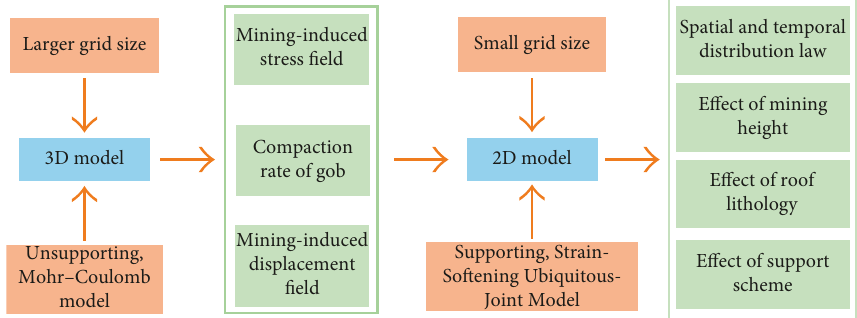
Figure 6: Schematic diagram for the multidimensional coupling numerical simulation method.